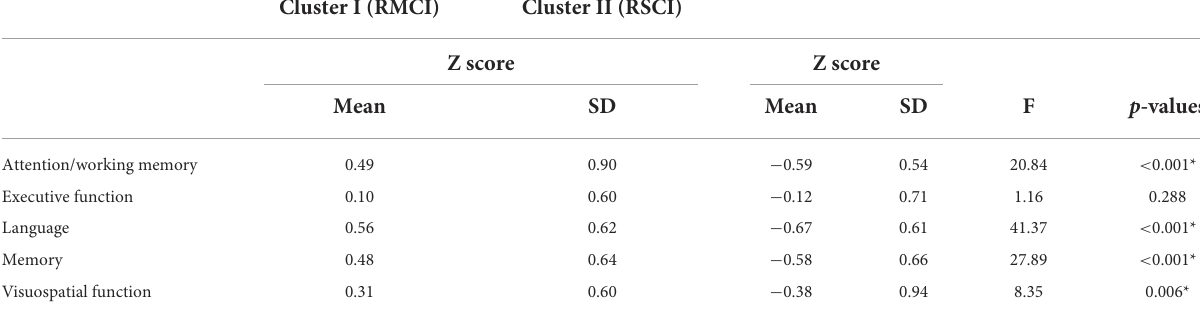
TABLE 5 Association of clusters with variables included in the cluster